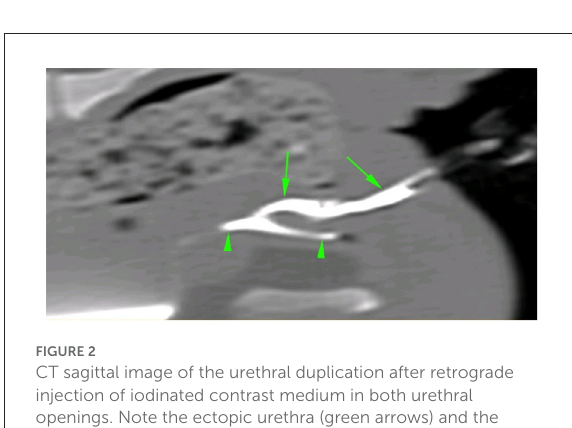
FIGURE2 CT sagittal image of the urethral duplication after retrograde injection of iodinated contrast medium in both urethral openings. Note the ectopic urethra (green arrows) and the orthotopic urethra (green